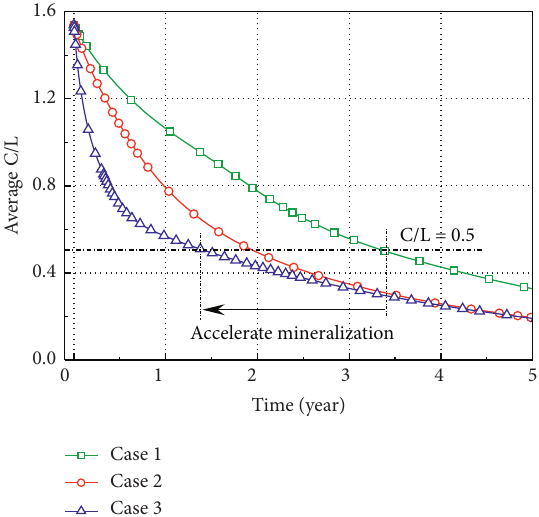
Figure 4: Average C/L for MSW under different recirculation conditions.